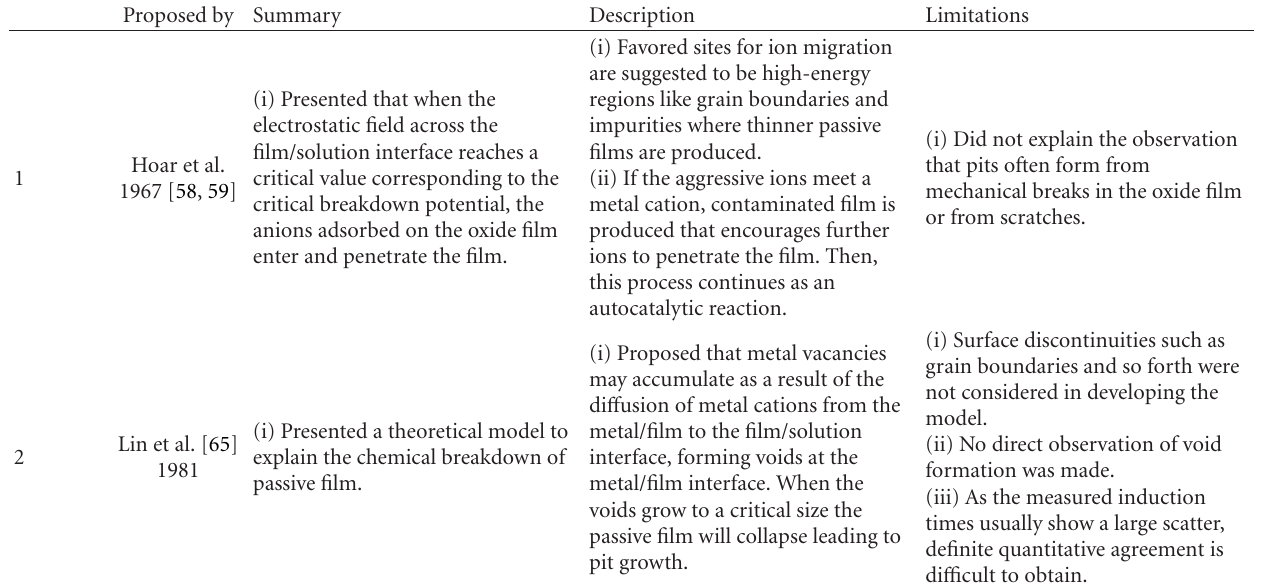
Table 6: Ion-migration and penetration